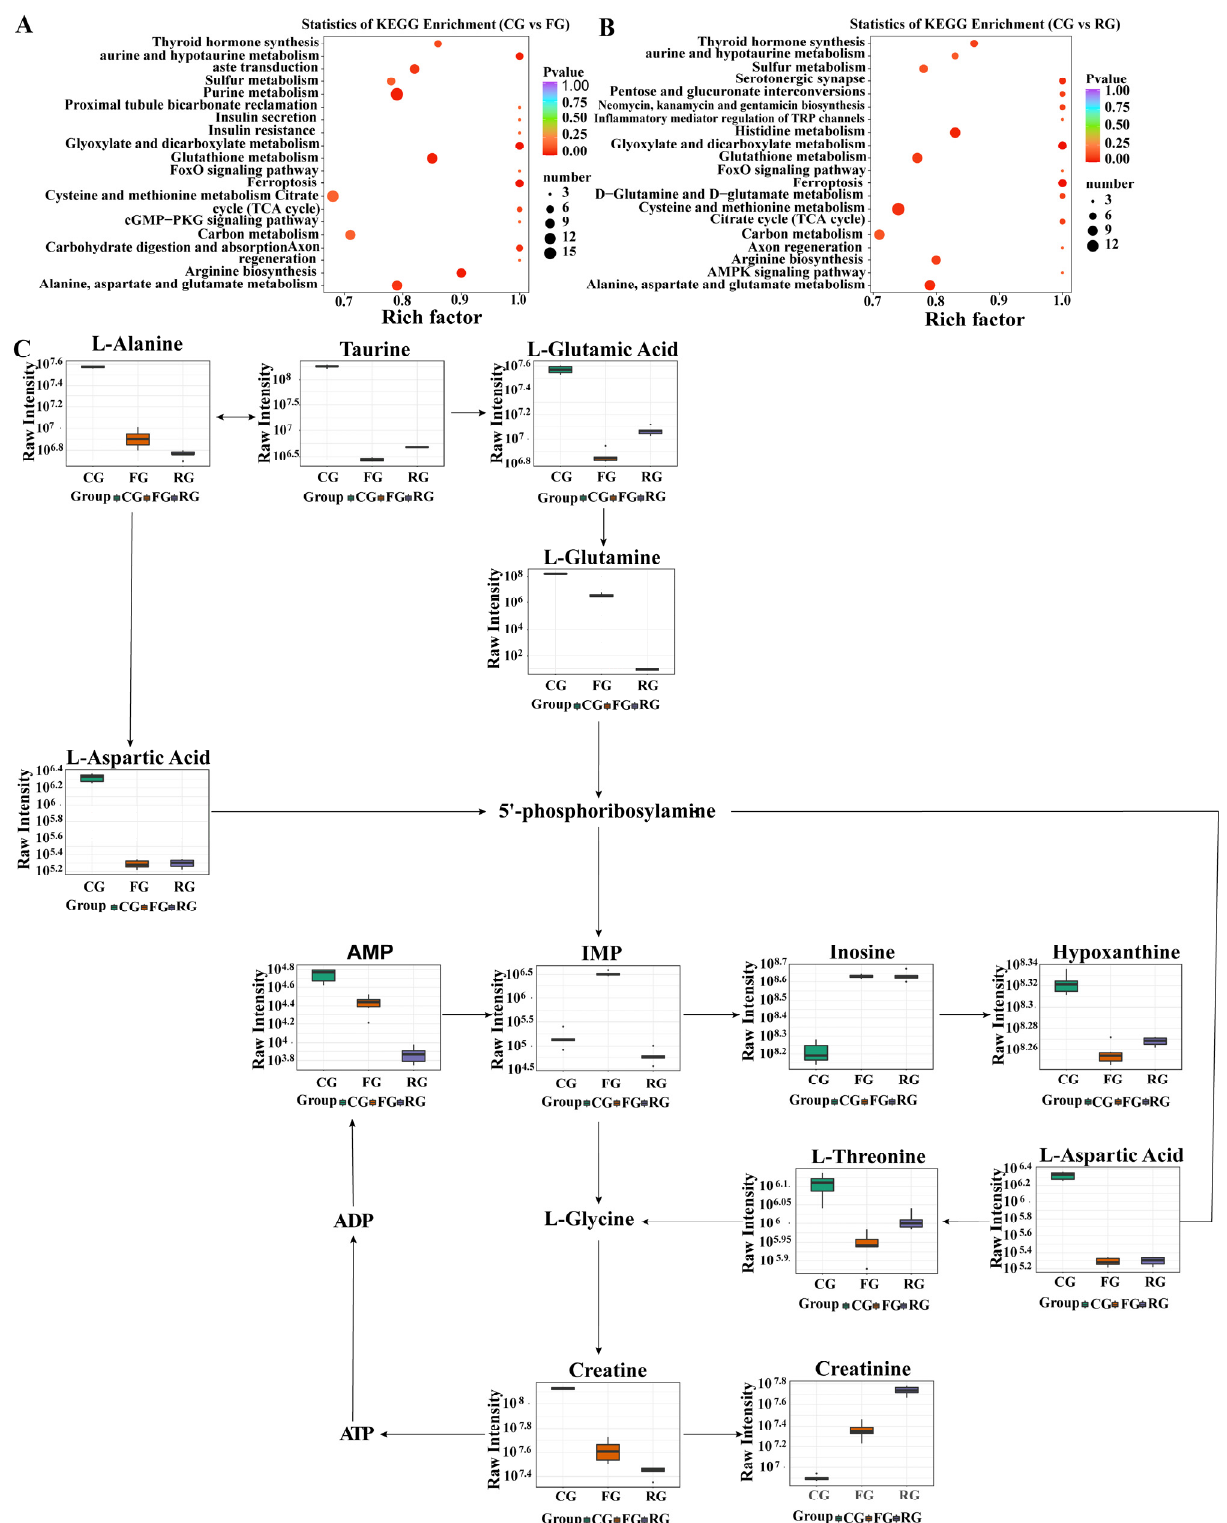
Figure 5. Dry-cured beef metabolic pathway analysis based on the significantly differentially ex- pressed metabolites in water-soluble compounds in CG—control group versus FG—fermented group ( A ) and CG versus RG—ripened group ( B ). Degree of enrichment was analyzed using a rich factor, p -value, and the number of dry-cured beef metabolites were enriched in each pathway. The size of the bubble indicates the amount of significantly differential metabolites in water-soluble compounds which were enriched in this pathway, and the point with different gradation of color represents the scope of the p -value. The higher value of the rich factor represents the higher degree